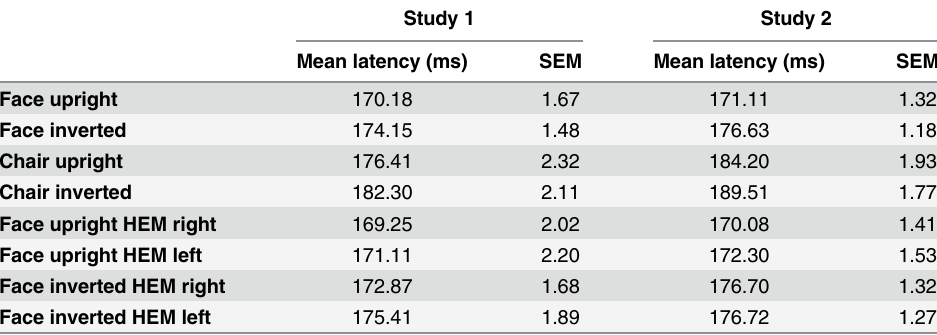
Table 3. Mean latencies (ms) and standard error of the mean (SEM) in response to perspective of neu- tral faces (upright vs. inverted) and chairs (upright vs. inverted); Hemisphere